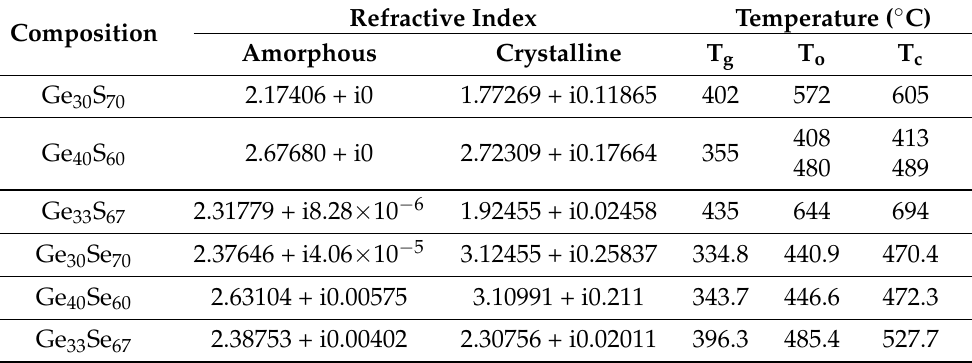
Figure 1. Schematic cross section of proposed ChG-capped optical fiber tip-based temperature sensor. Table 1. Summary of the measured complex refractive indices of synthesized glasses in amorphous and crystalline phases at 1550 nm